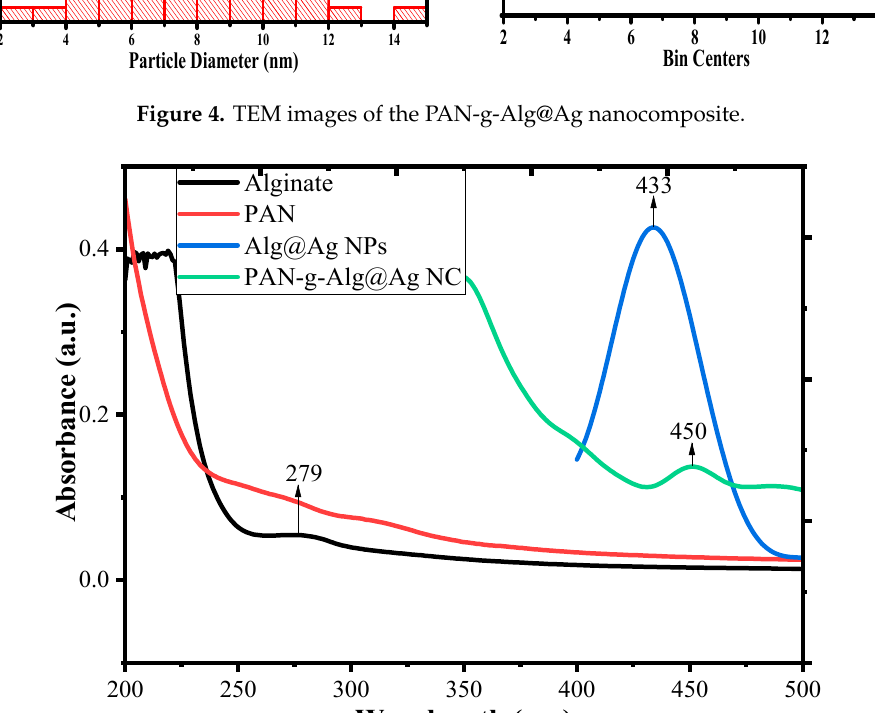
Figure 5. UV–Vis spectrum of alginate (black line), PAN (Red line), Alg@Ag NPs (blue line), and PAN- g-Alg@Ag NC (green line). and PAN-g-Alg@Ag NC (green